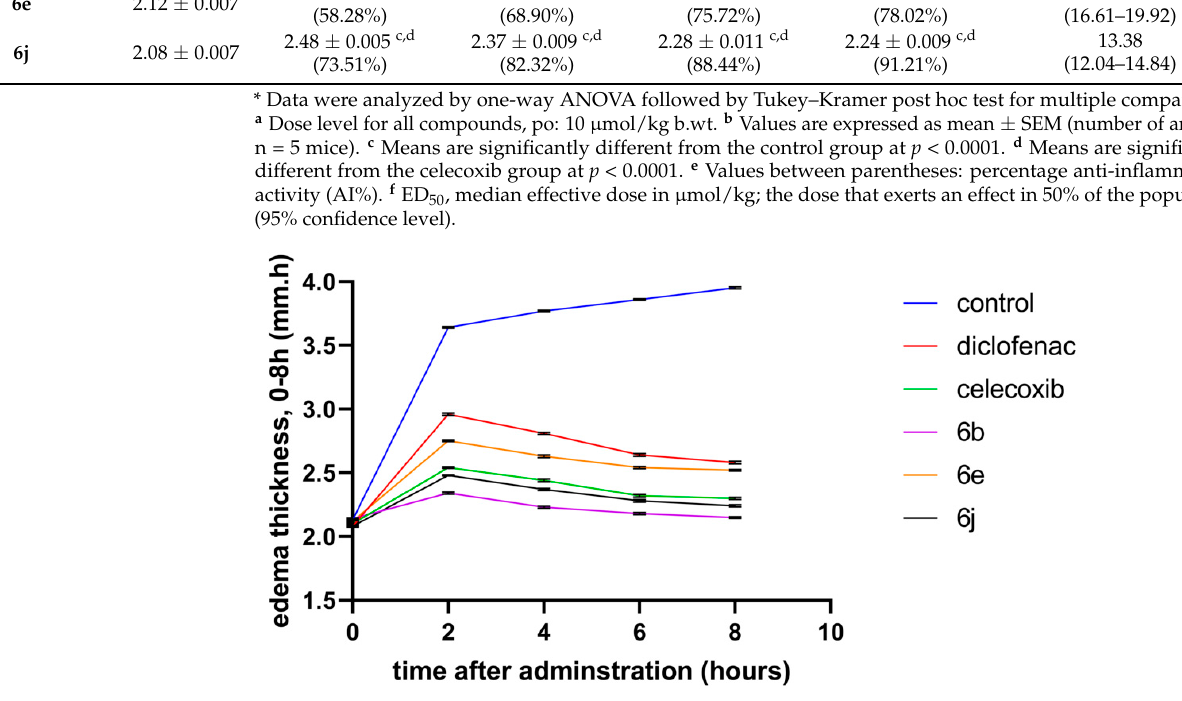
Figure 2. Effects of the tested compounds 6b , 6e and 6j as well as celecoxib and diclofenac as positive controls on the thickness of carrageenan-induced paw edema in mice along interval of 0–8 h after carrageenan injection (mm) in a dose of 10 µmol/kg.